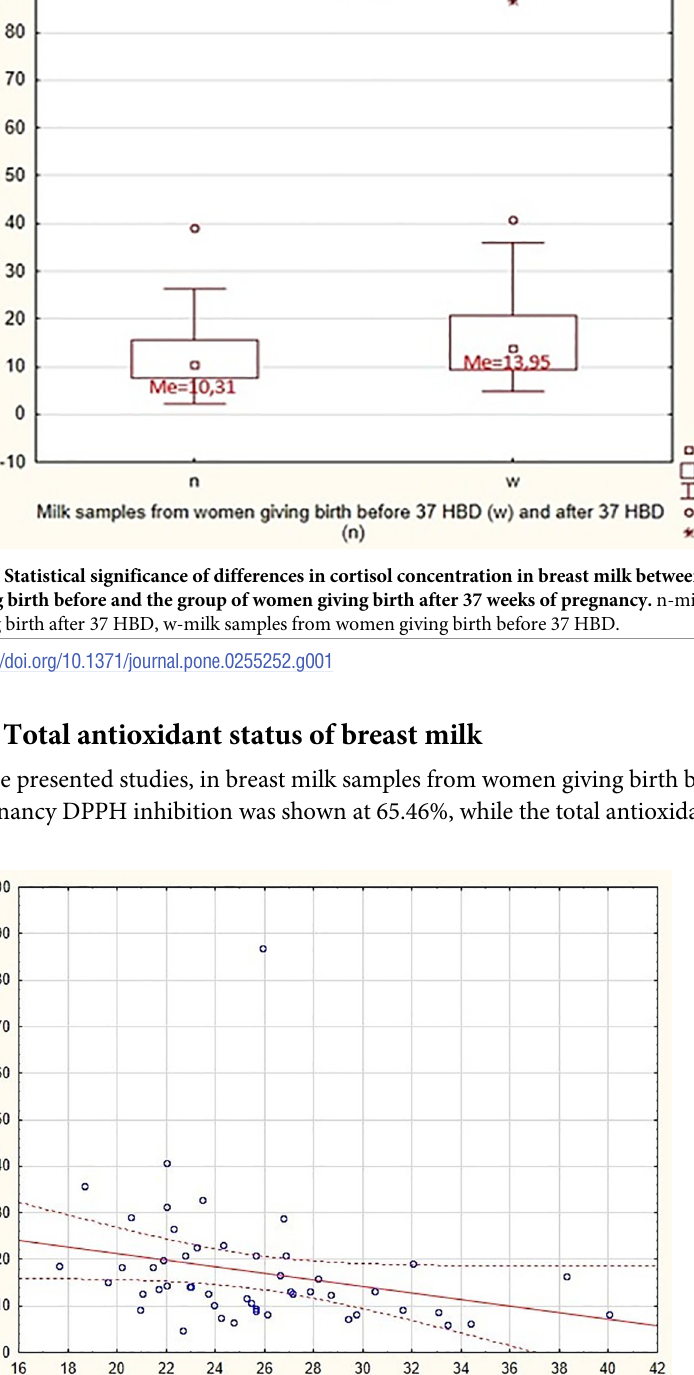
Fig 2. Graphic representation of the correlation between cortisol concentration in milk samples from women giving birth before 37 weeks of pregnancy and the mother’s BMI (y = 35.308–0.701x, r = -0.419, p = 0.002).